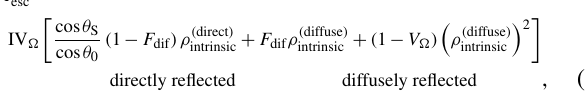
of the illumination angle at each point